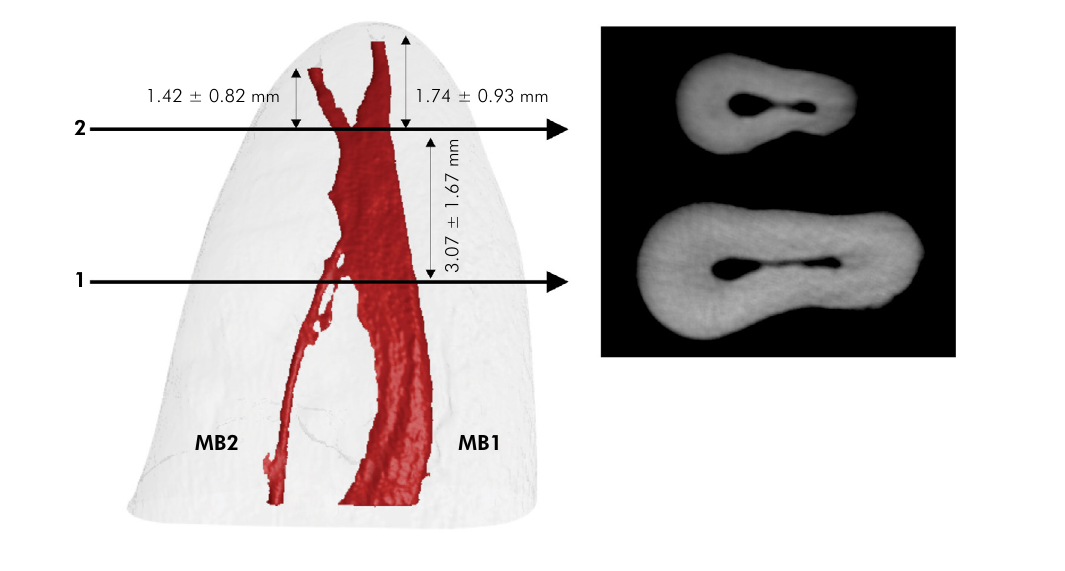
Figure 3. Two and three-dimensional models of specimens showing a band-shaped isthmus and the mean of the measurement for the 16 specimens using CTAn software (Bruker